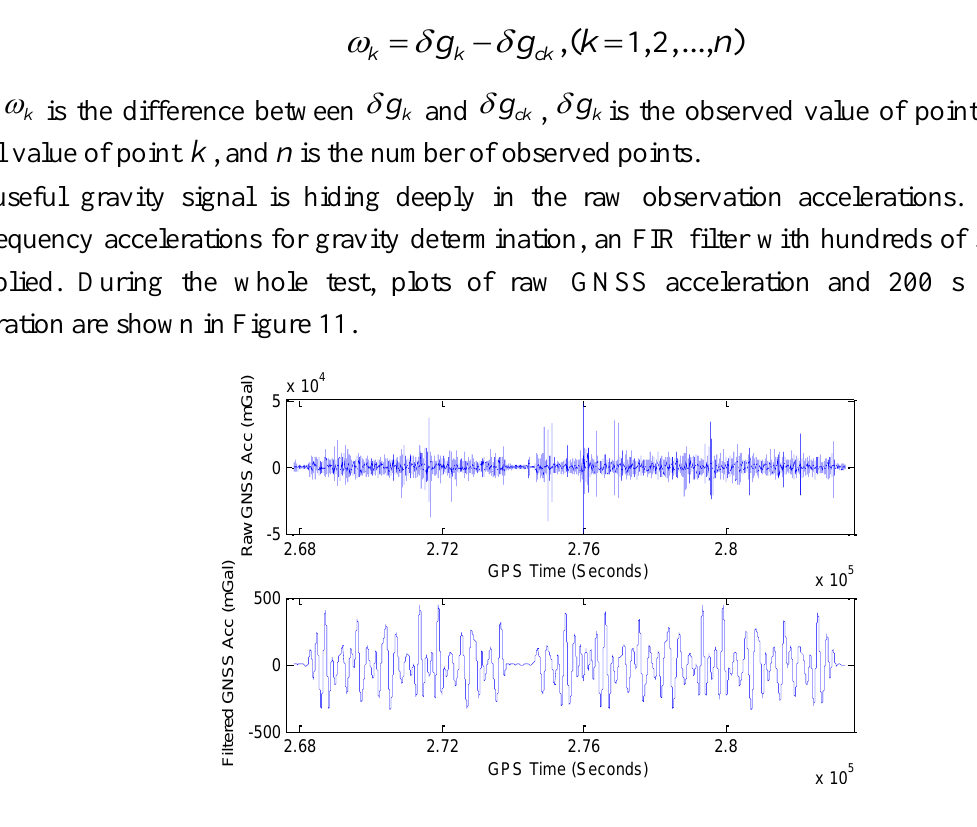
Figure 11. Plots of raw and 200 s filtered GNSS accelerations.